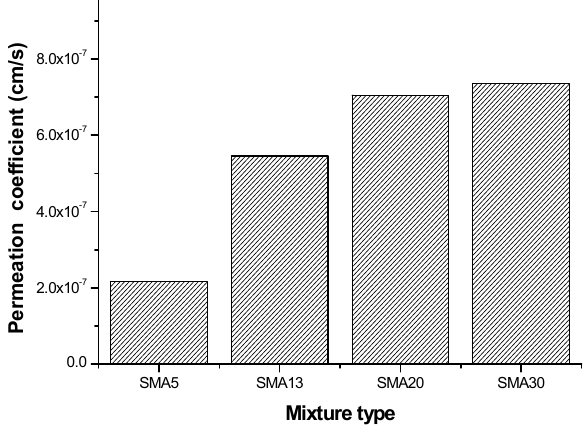
Figure 3. Mixture types and permeability coefficients.